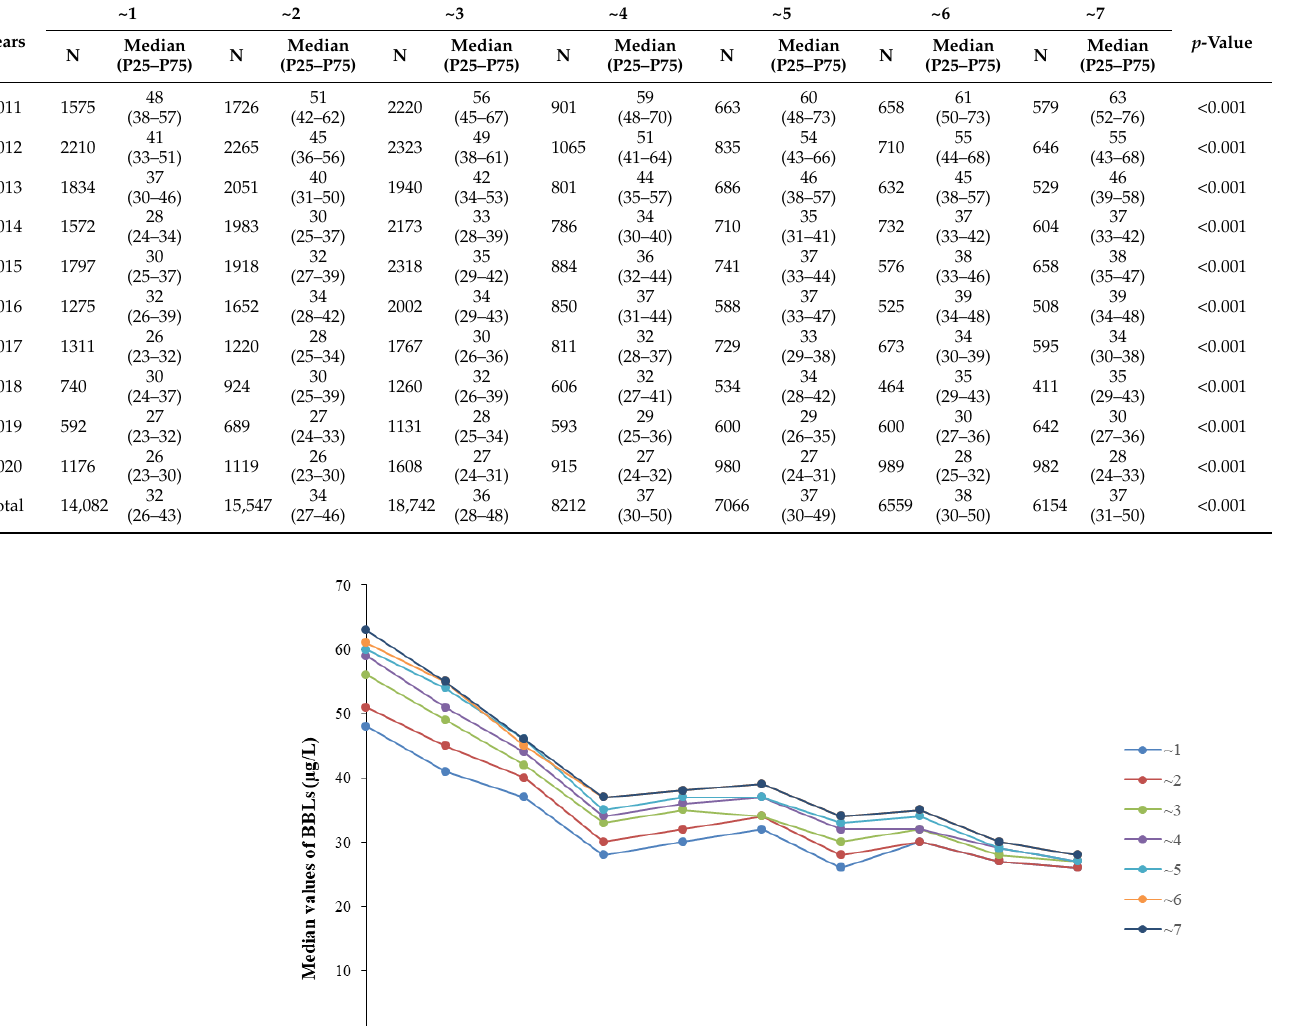
Table 2. The BLLs ( µ g/L) of children in different age groups during 2011–2020.